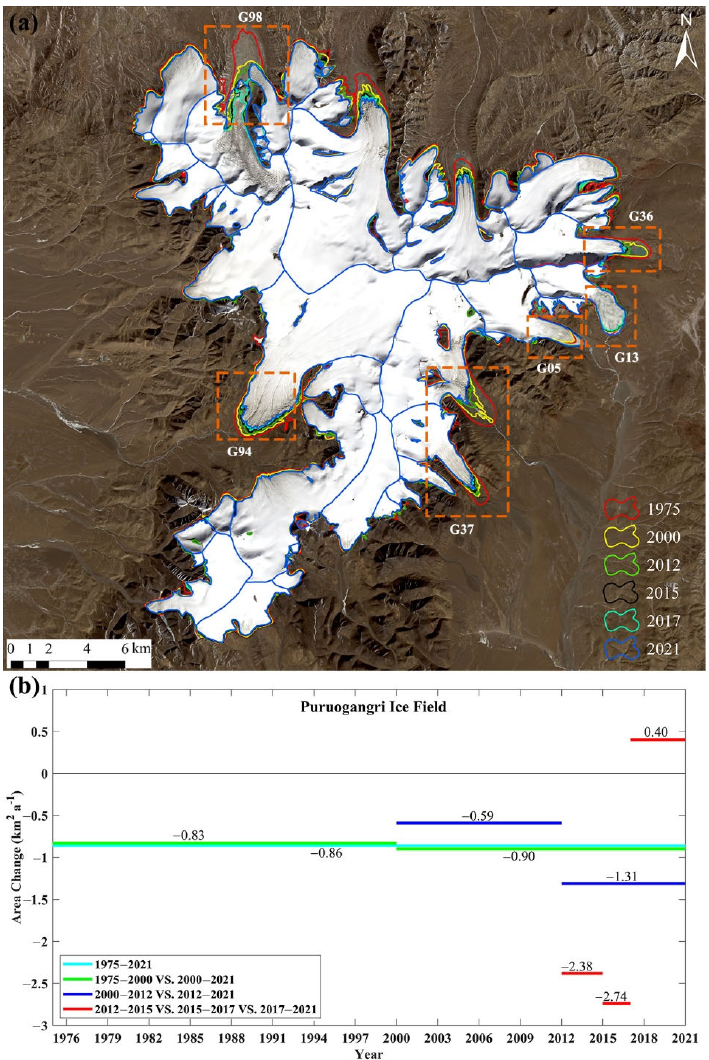
Figure 6. ( a ) The glacier boundaries in 1975, 2000, 2012, 2015, 2017 and 2021 (the background is the Landsat 8 image from 2021); ( b ) the rates of area change in the Puruogangri Ice Field over the different periods.